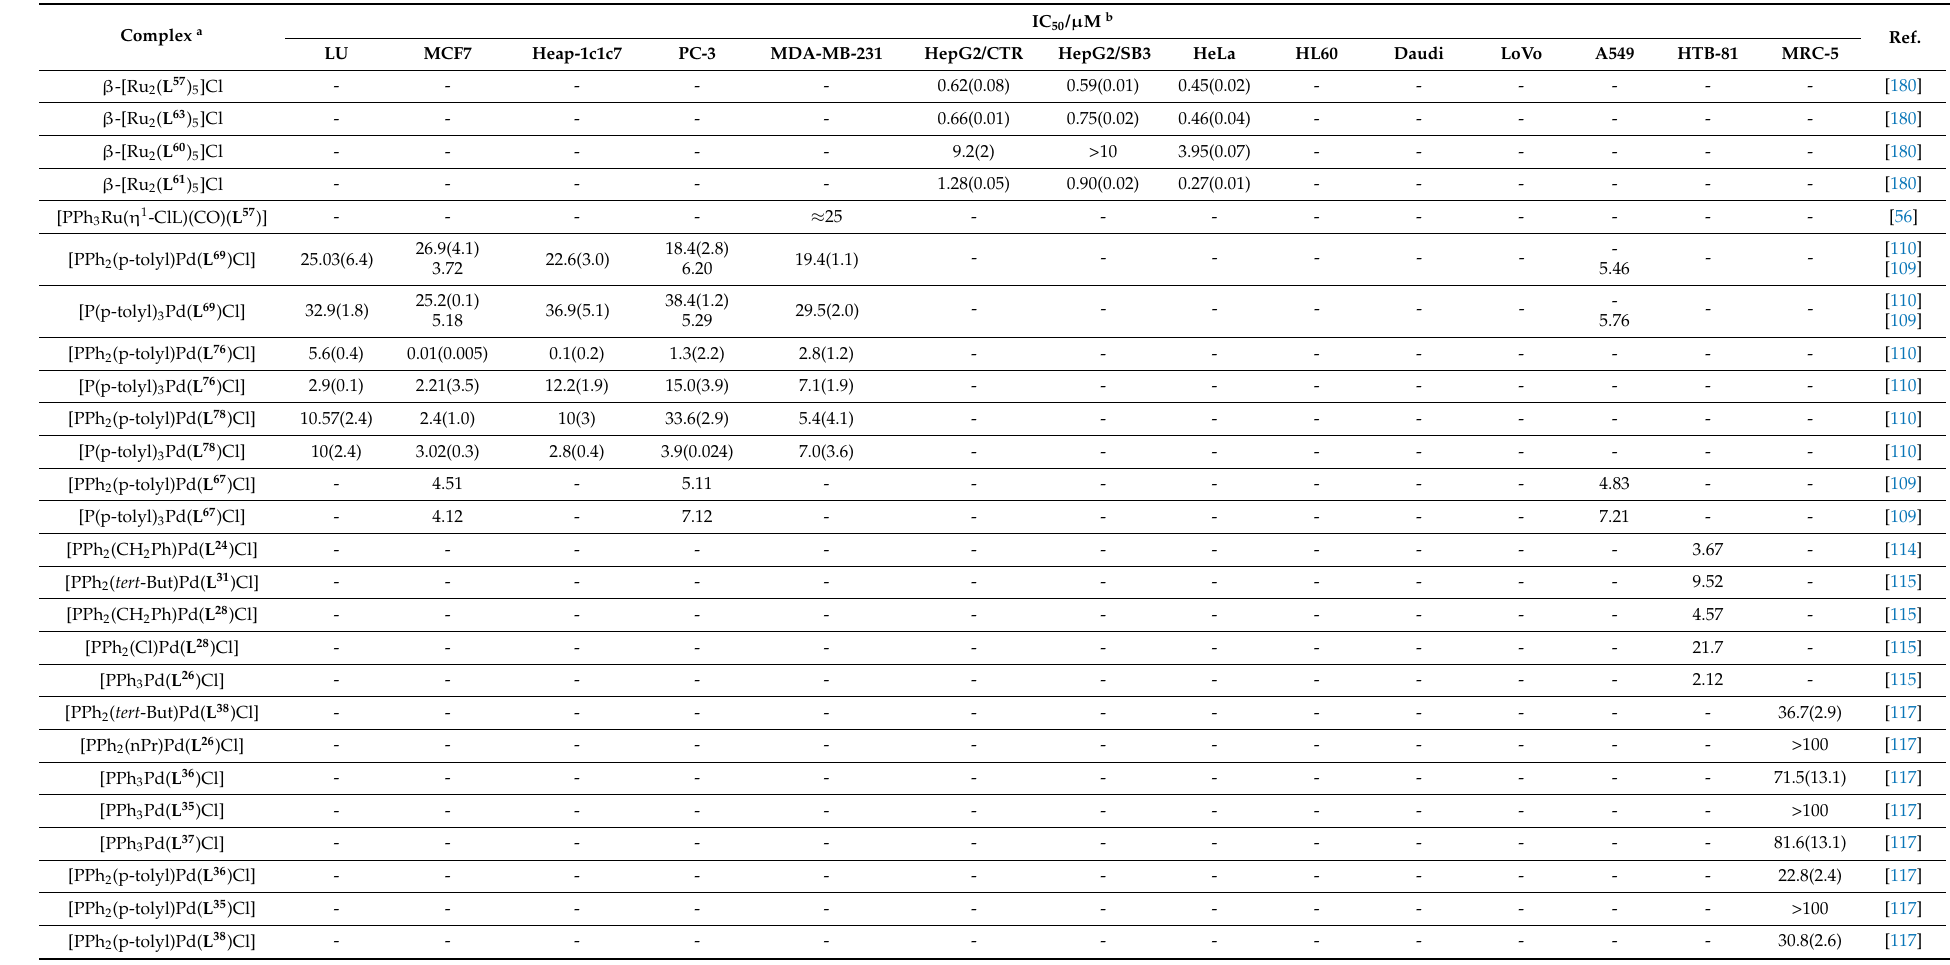
Table 12. In vitro cytotoxicity of platinum-group metal dithiocarbamate